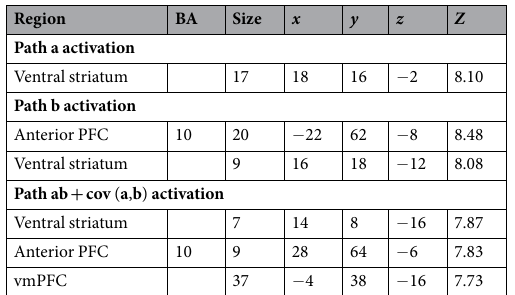
Table 2. Path a-, b- and axb-related brain activations. Note : The table was obtained using whole-brain multilevel mediation analysis at onset of wine tasting in N = 30 subjects. Regions listed survived a whole-brain threshold of p < 0.001 uncorrected at the voxel level and small volume correction of p FWE < 0.05. BA: Brodmann area; vmPFC: ventromedial prefrontal cortex; PFC: prefrontal